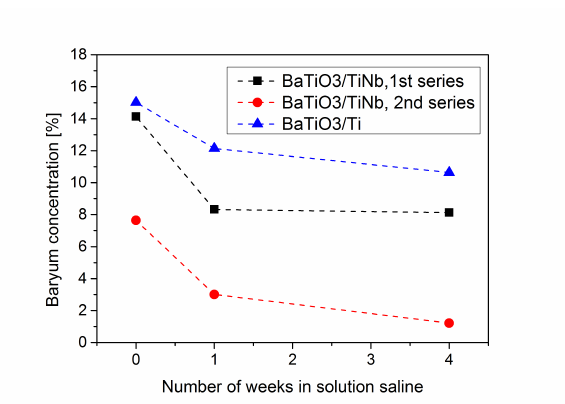
Figure 2. Decrease of barium concentration due to 3 on TiNb an action of solution